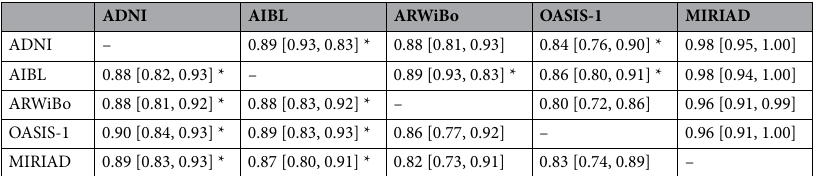
Table 3. Generalization performance of the classifiers for the classification between HC and patients with Alzheimer’s disease. In this table, the rows indicate the dataset where the classifier is trained and the columns indicate the dataset where the performance was tested. The area under the receiver operating characteristic curve is shown with the upper and lower bound of its 95% confidence interval. Performance significantly different from the normative approach calculated using the confidence interval of the difference between the approach across the bootstrap scheme is indicated by “*”.